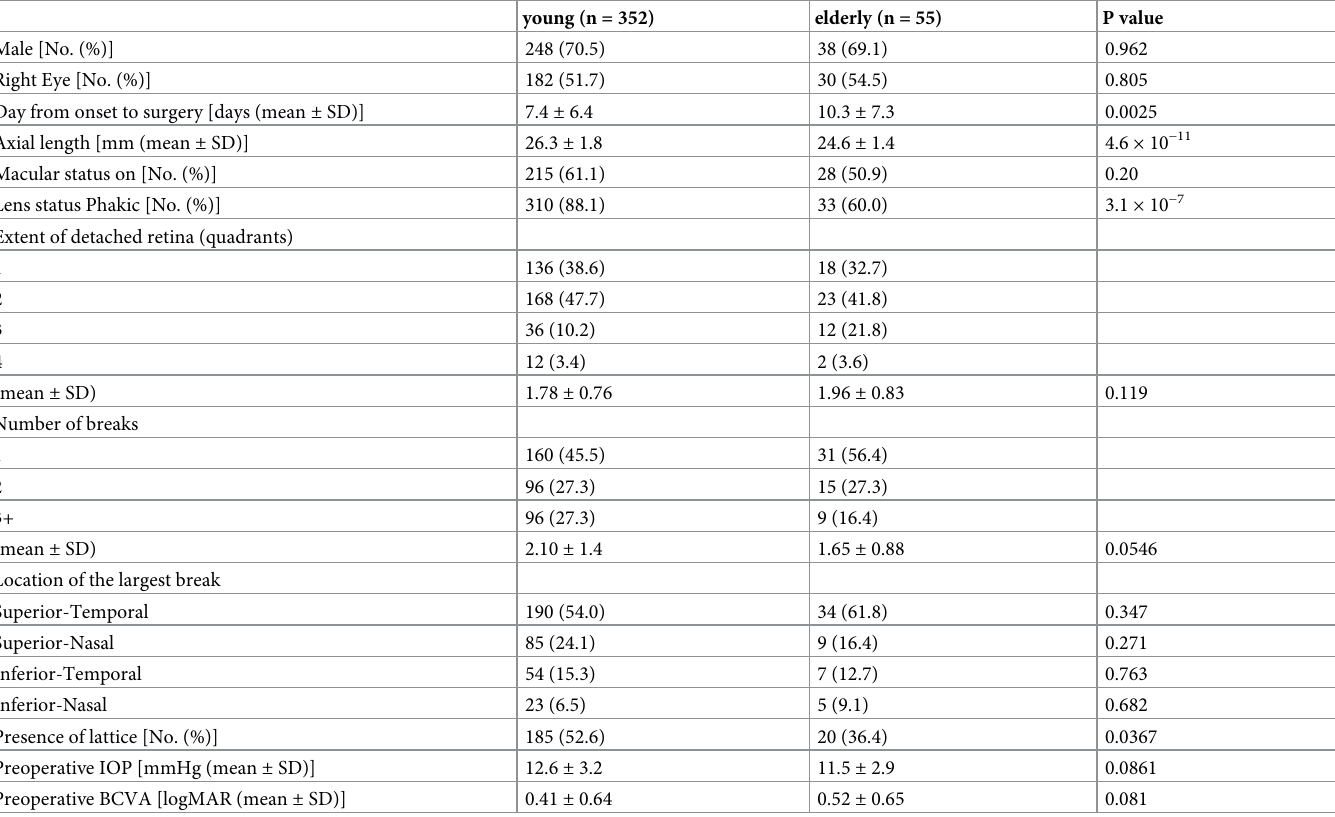
Table 2. Baseline patient characteristics in elderly and younger groups.